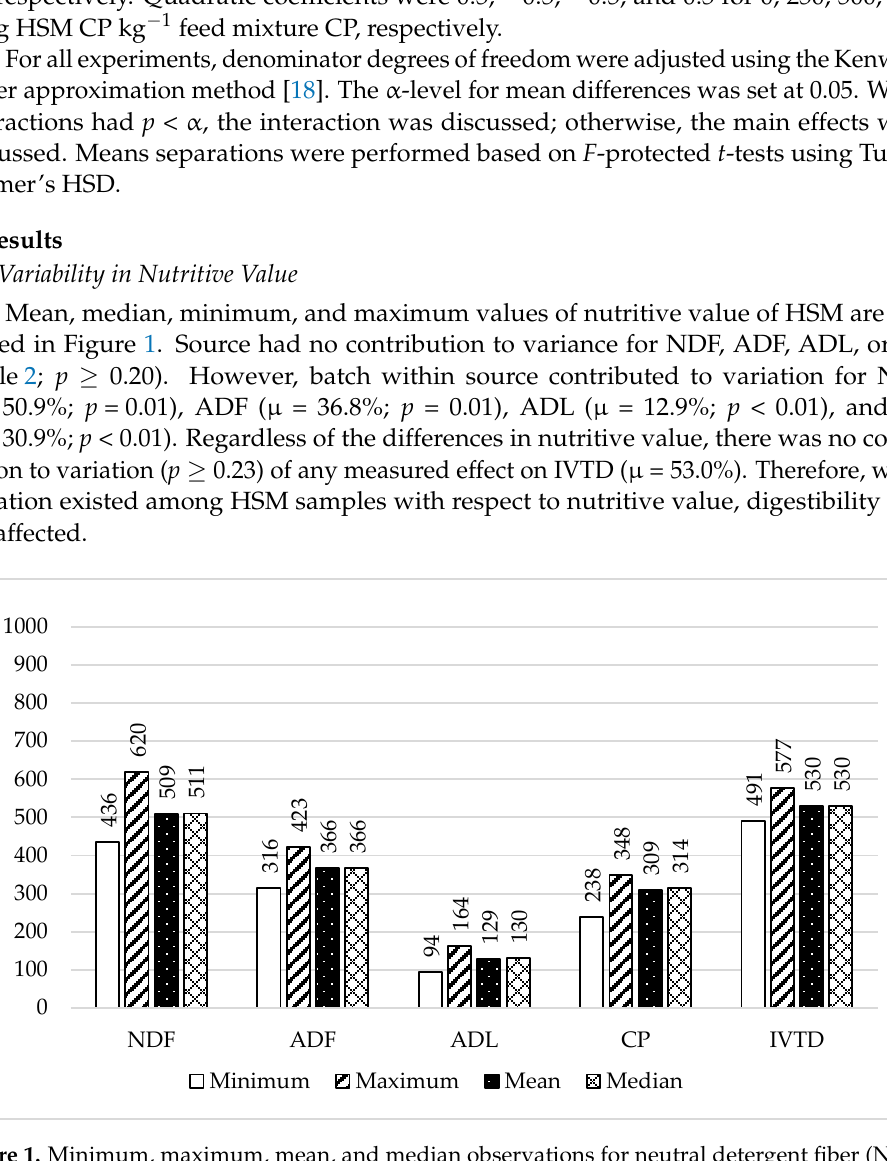
Figure 1. Minimum, maximum, mean, and median observations for neutral detergent fiber (NDF), acid detergent fiber (ADF), acid detergent lignin (ADL), crude protein (CP), and in vitro true digestibility (IVTD) of 15 hempseed meal samples collected from four oil processing facilities. Table 2. Random effects estimates of neutral detergent fiber (NDF), acid detergent fiber (ADF), acid detergent lignin (ADL), crude protein (CP), and in vitro true digestibility (IVTD) from 15 hempseed meal samples collected from four oil processing